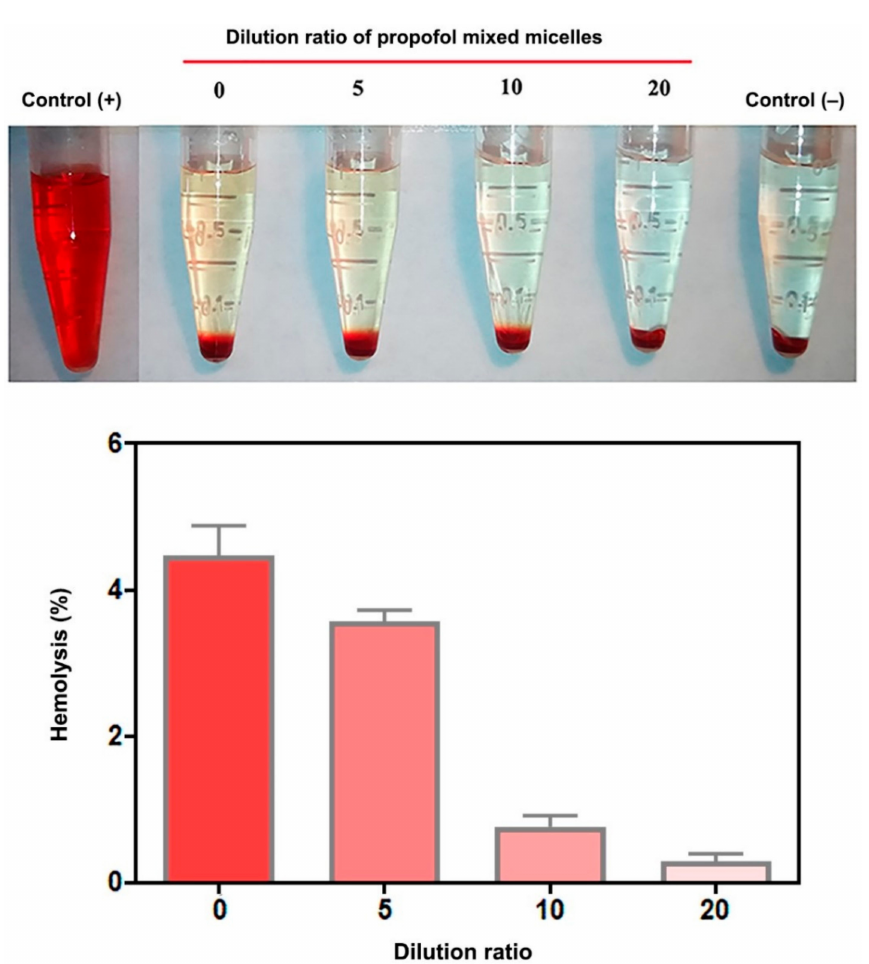
Figure 6. Hemolysis test results of the propofol-mixed micelles at different dilution ratios ( n =